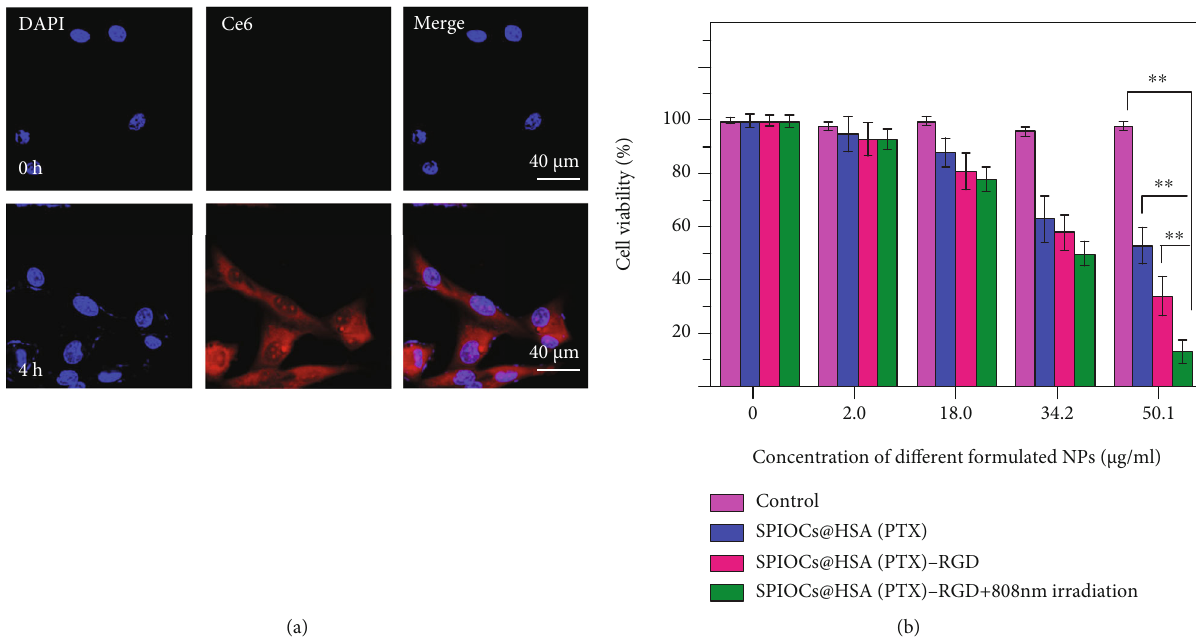
Figure 3: (a) Internalization of Ce6-labeled SPIOCs@HSA-RGD into U87 cells after incubation for 4h; (b) in vitro antitumor ability of SPIOCs@HSA(PTX)-RGD at di ff erent PTX concentrations ( ∗∗ P < 0 : 01